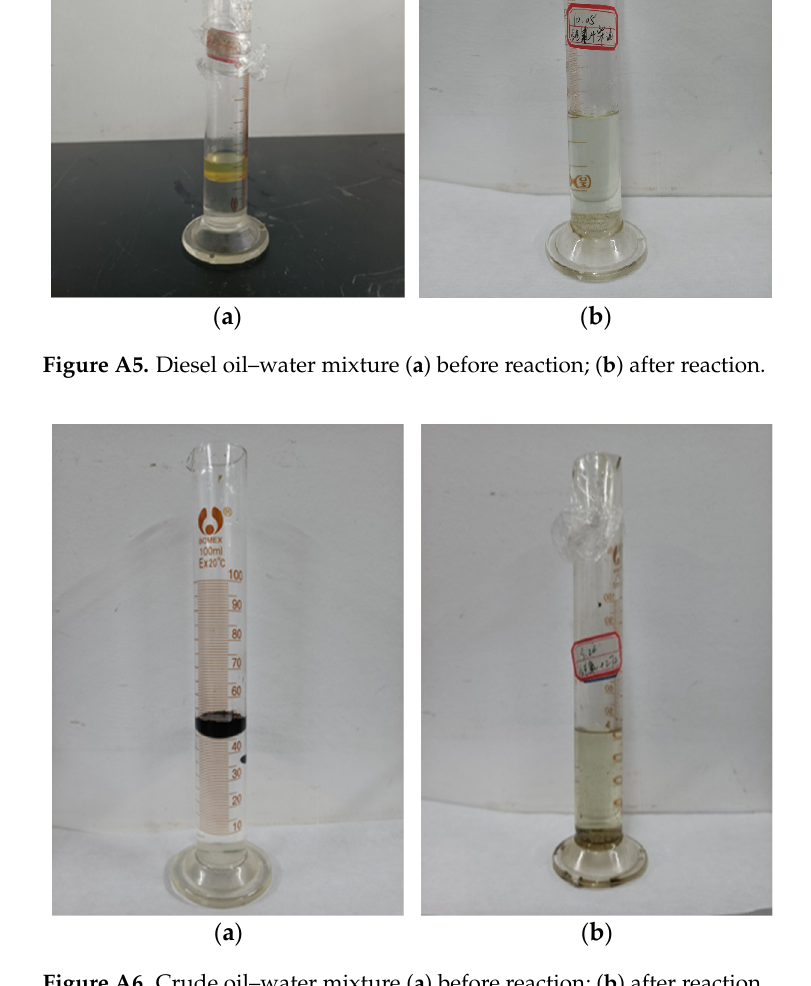
Figure A6. Crude oil–water mixture ( a ) before reaction; ( b ) after reaction.